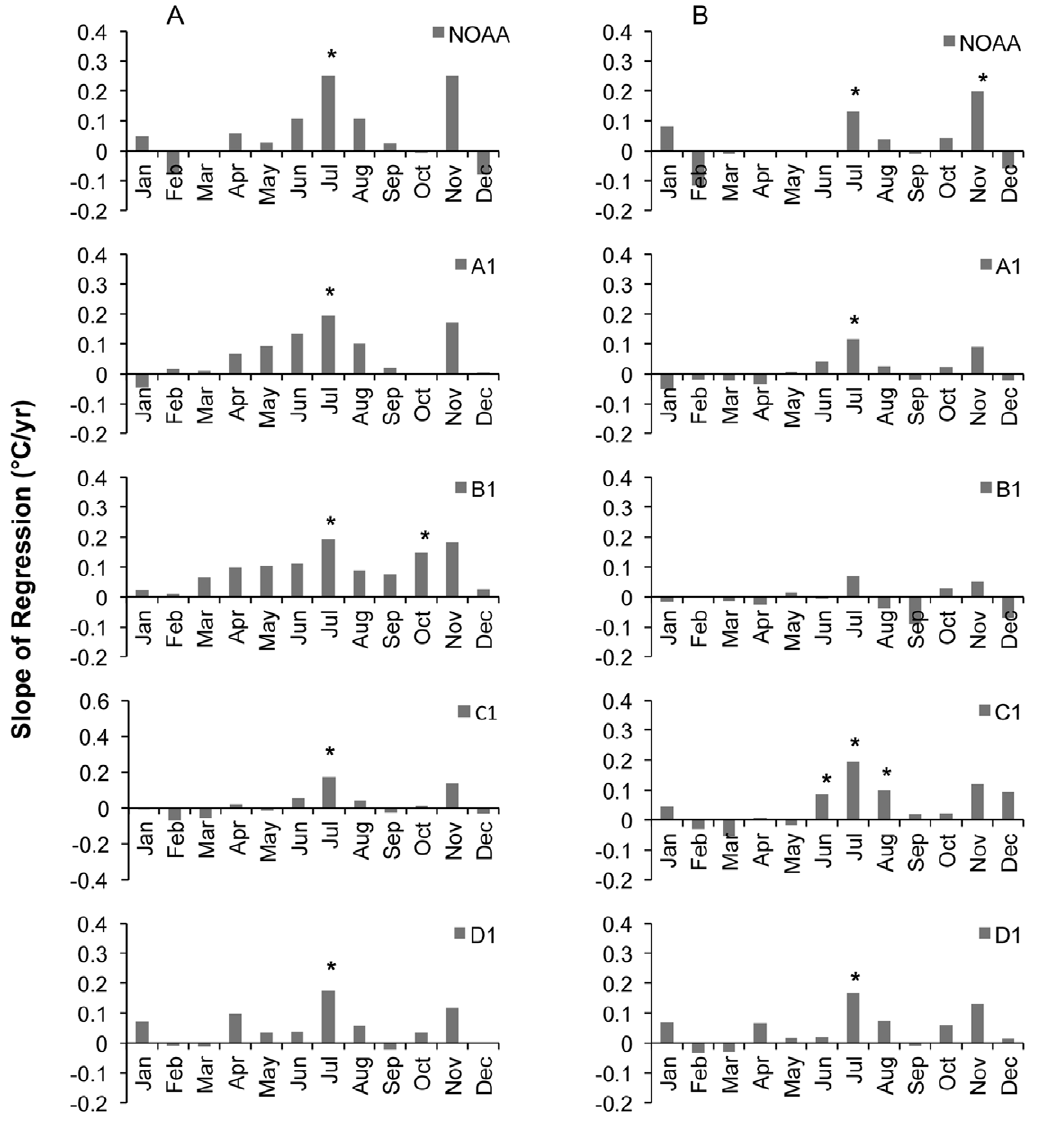
Figure 4. Monthly temperature trends derived by linear regressions over a twenty-year period (1989–2008) across the RMFR transect. Trends shown as changes in the average monthly (A) maximum and (B) minimum temperatures ( u C) per year. Significance level of regression denoted by * p , 0.05.